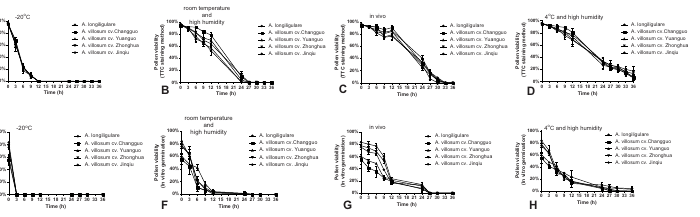
Fig 3. Pollen viability of the five cultivars ‘ A . longiligulare’, ‘ A villosum cv . Changguo’, A . villosum cv . Yuanguo’, ‘ A . villosum cv . Zhonghua’ and ‘ A . villosum cv . Jinqiu’, stored in vivo at 4˚C and high humidity and at room temperature as tested by two methods. TTC staining method (A–C) and in vitro germination test (D–F).